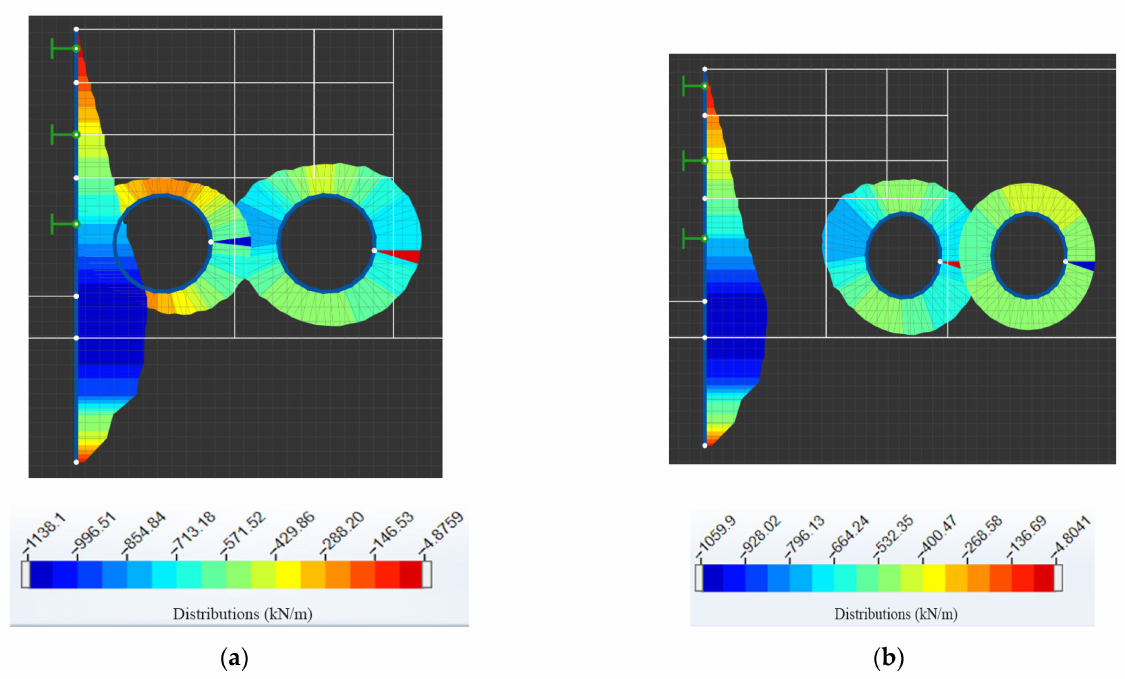
Figure 18. Axial force diagram under different horizontal distance L in stage (4): ( a ) L = 0.33 H and ( b ) L = 1.0